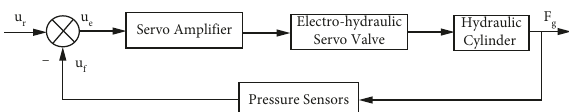
Figure 4: Block diagram of the machine’s hydrostatic guide control system.